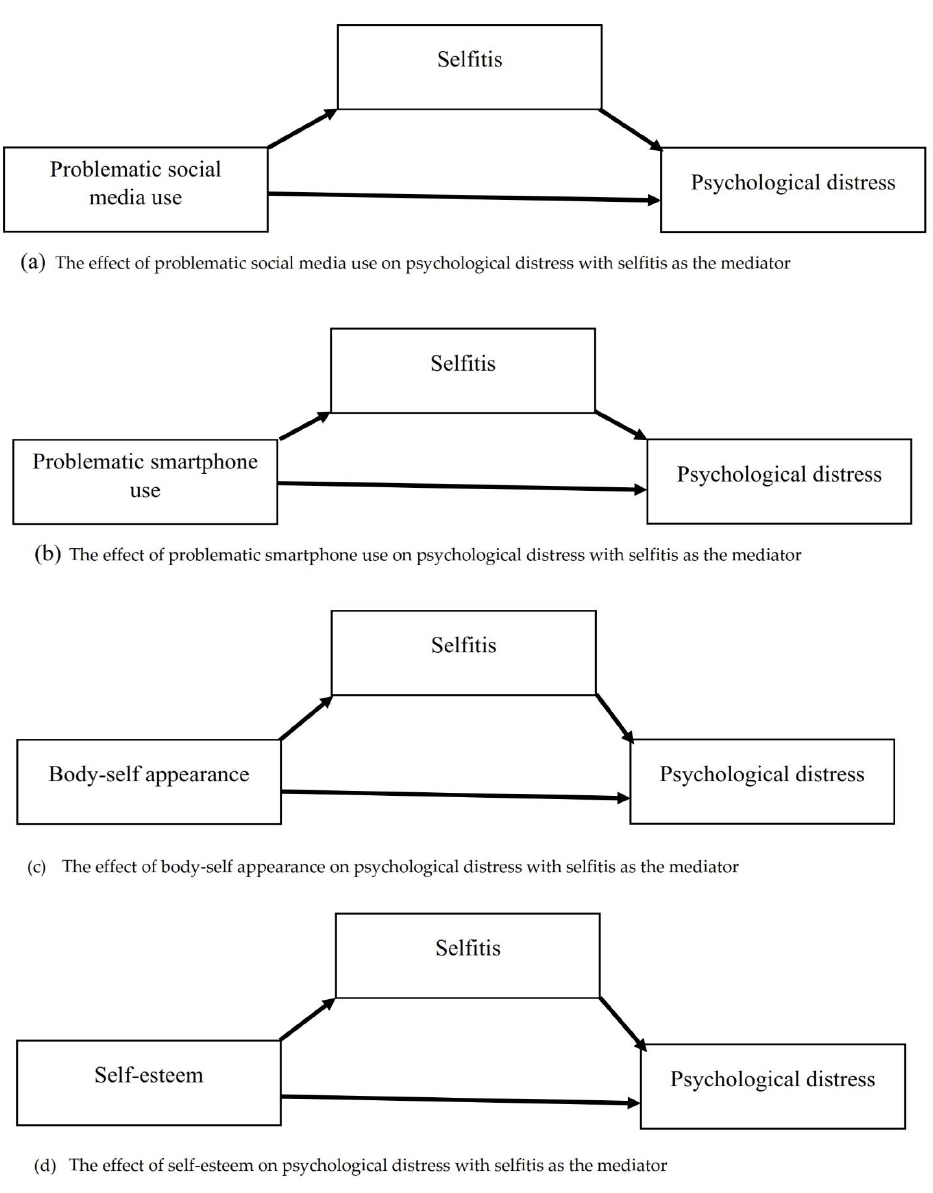
Figure 1. The hypothesized mediating role of selfitis in the associations between self-esteem, problematic social media use, problematic smartphone use, body-self appearance, and psychological distress among young Ghanaian adults.